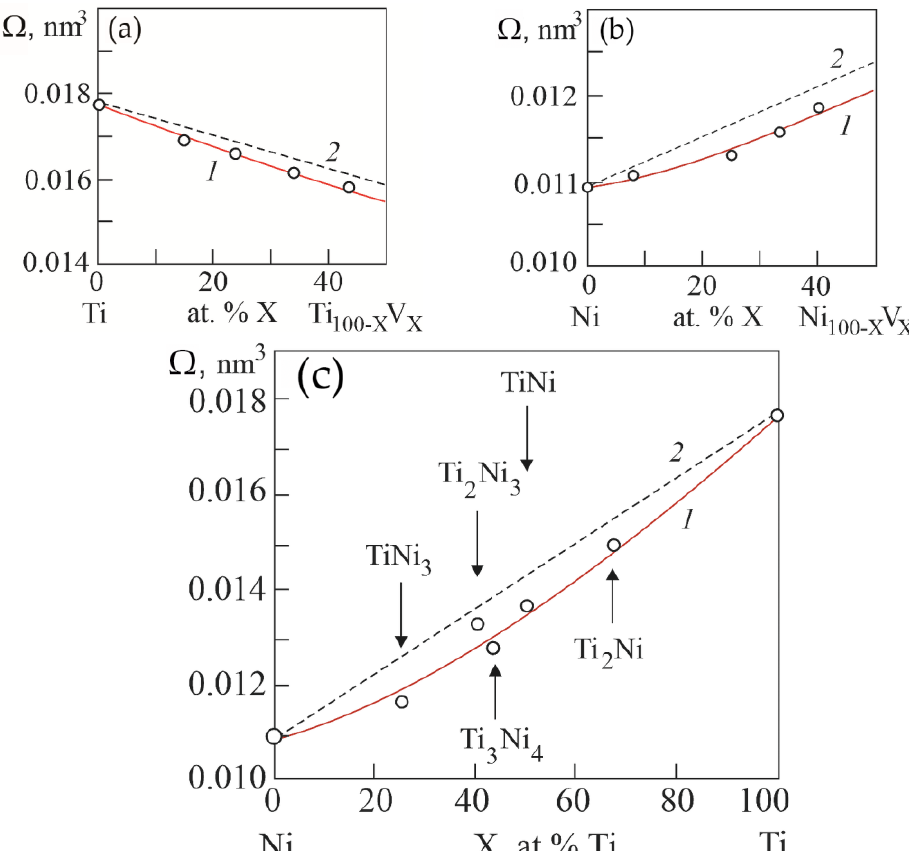
Figure 9. Concentration dependences of atomic volumes in binary systems Ti – V ( a ), Ni – V ( b ) and Ni – Ti ( c ). Curves 1 were obtained from the concentration dependences of the lattice parameters in the considered systems. Curves 2 are theoretical dependences calculated according to Zen’s law.